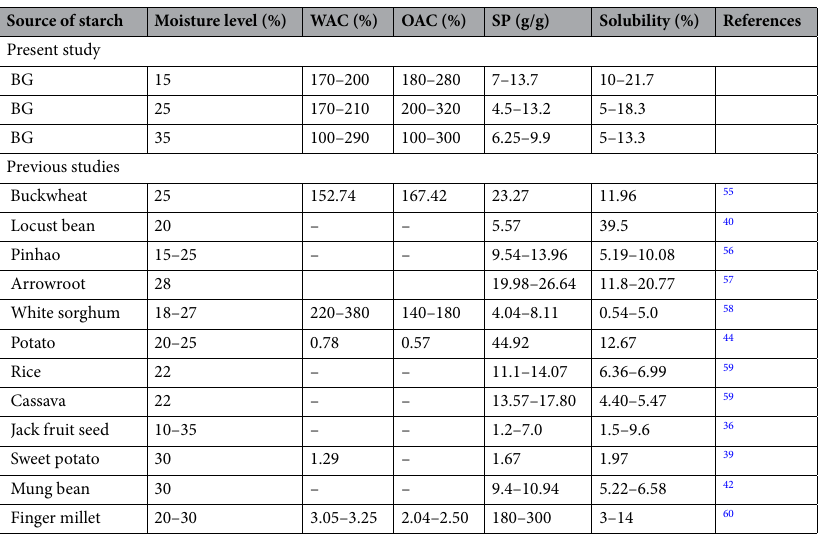
Table 5. Comparison of some functional properties of various heat-moisture treated starches in previous and present studies. WAC: water absorption capacity; OAC: oil absorption capacity; SP: swelling power; BG: Bambara groundnut.